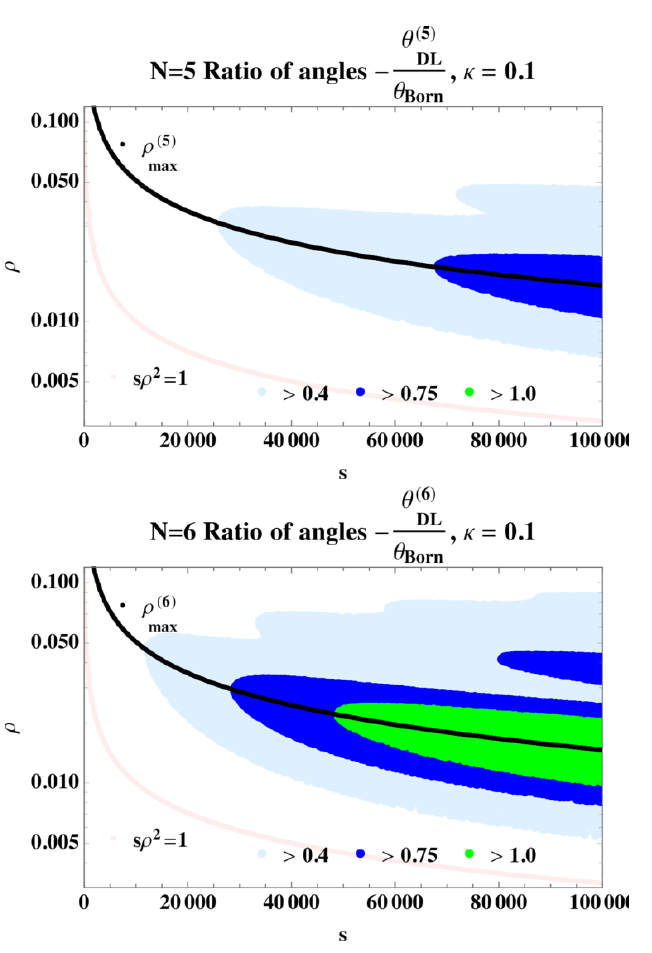
Figure 13 . Regions in impact parameter and energy space where the DL resummation e(cid:11)ects are large ( N =5 up, N =6 bottom). When the ratio (cid:0) (cid:18) it is bigger than 0.4 and 0.75, it corresponds to a large correction but still with a positive